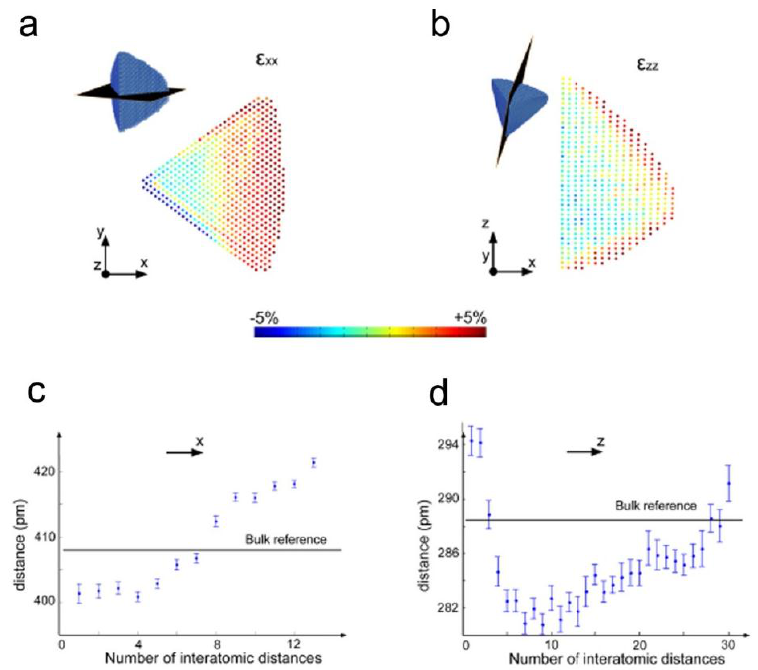
Figure 6. ( a , b ) ε xx and ε zz strain field showing surface relaxation in both directions. The colour scale indicates the expansion of the lattice parameter with respect to a reference; ( c , d ) The surface relaxation was confirmed by measuring the lattice parameter on slices through the reconstructions at the positions indicated in ( a , b ) [75].